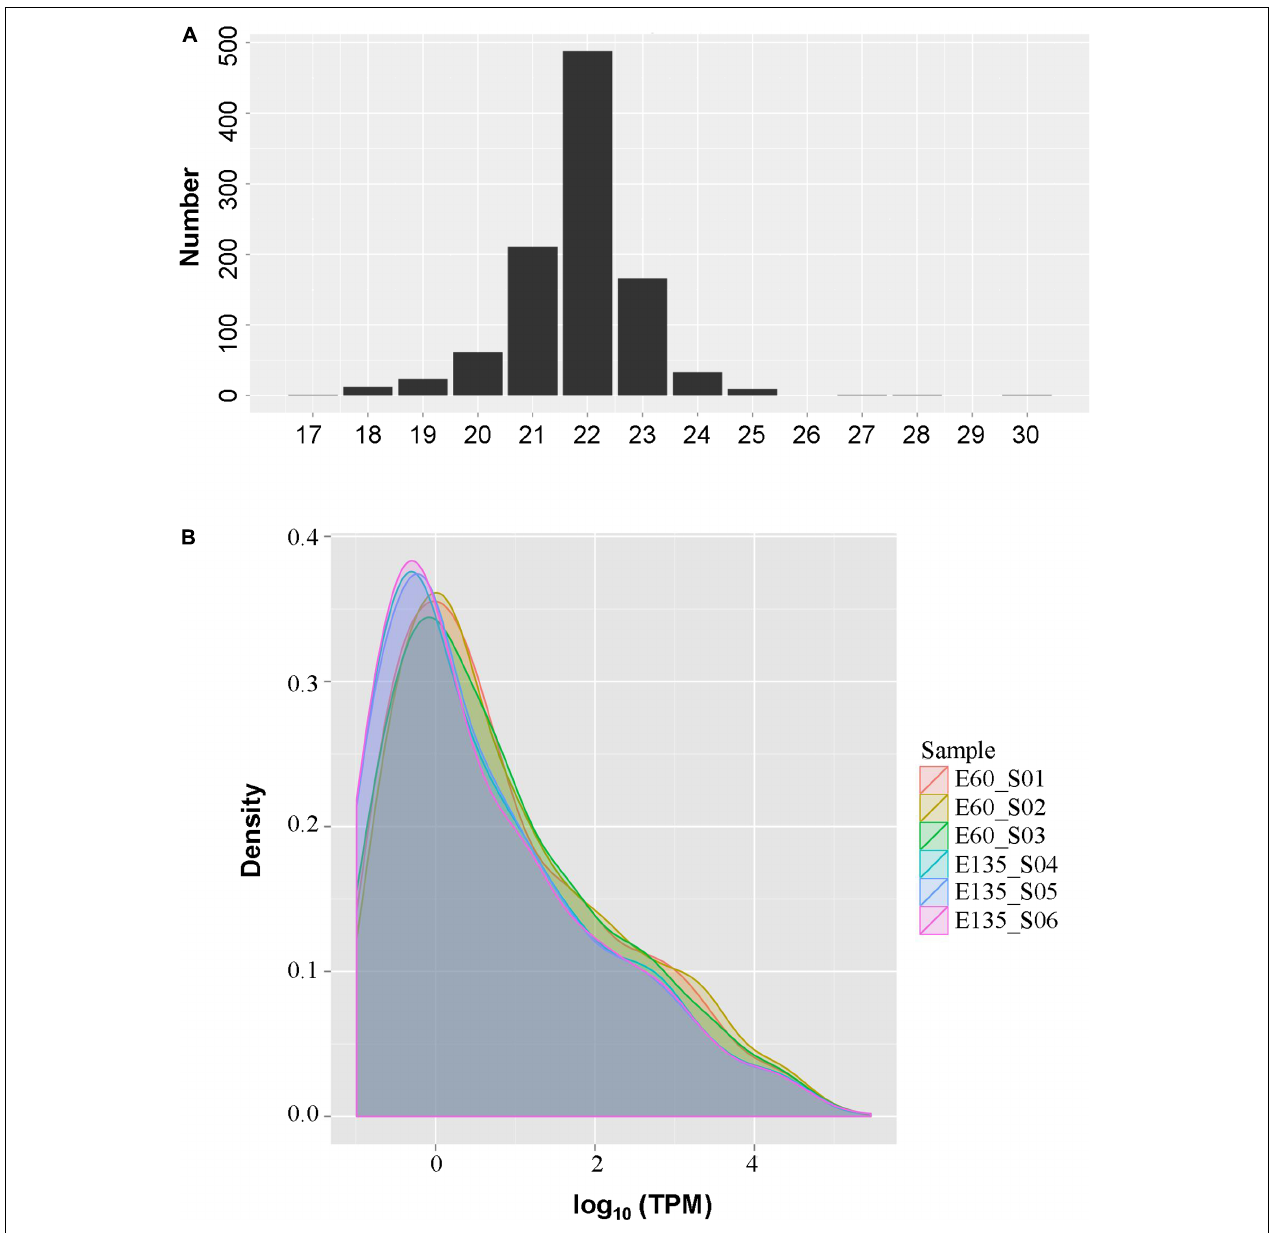
FIGURE 2 | The size (A) and expression density (B) distributions of the microRNAs (miRNAs) in goat rumen